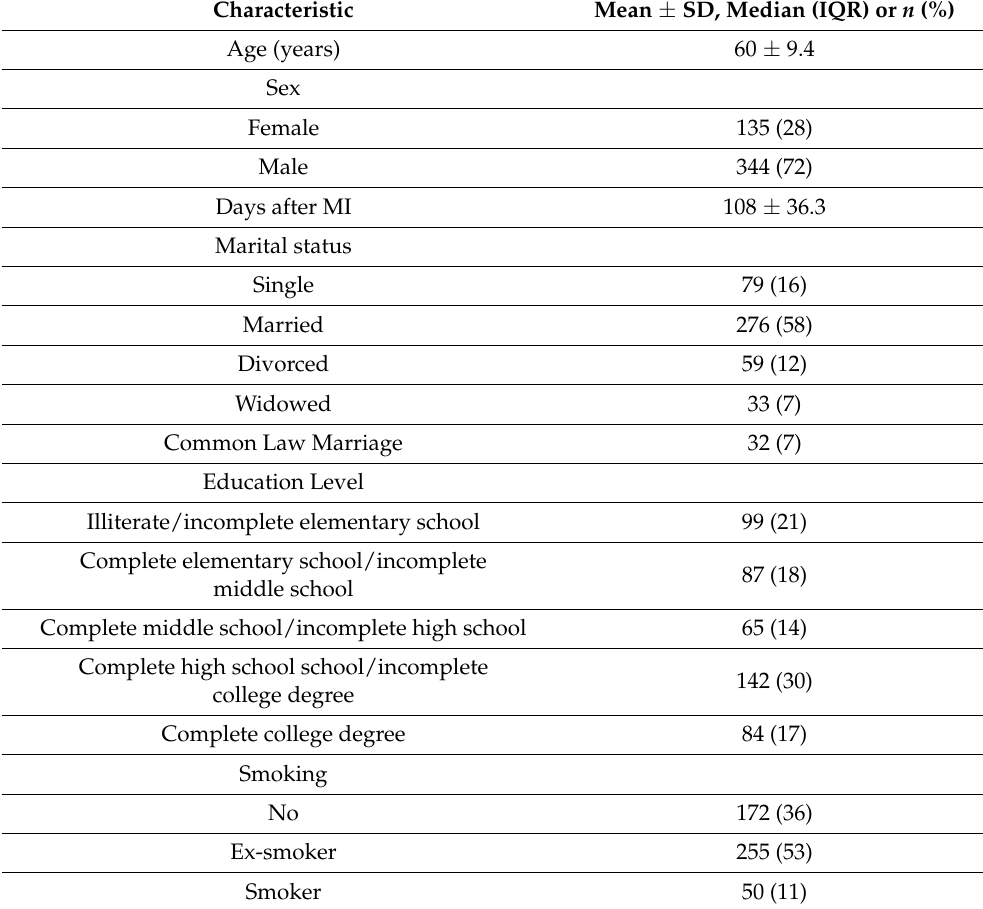
Table 1. Demographic, clinical, lifestyle, laboratory, and dietary intake characteristics of participants ( n =